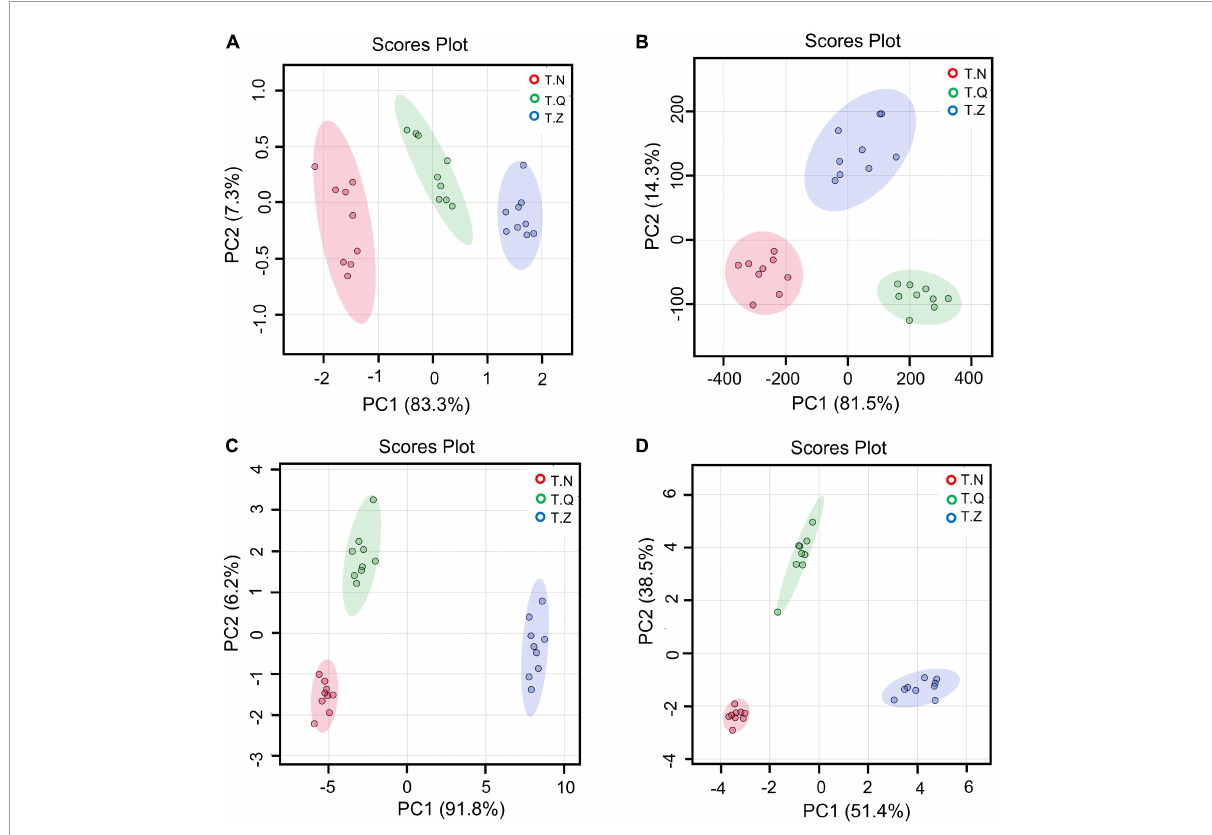
FIGURE4 Score plots of PLS-DA of three origin hairtail: (A) mineral, (B) amino acid, (C) fatty acids, and (D)